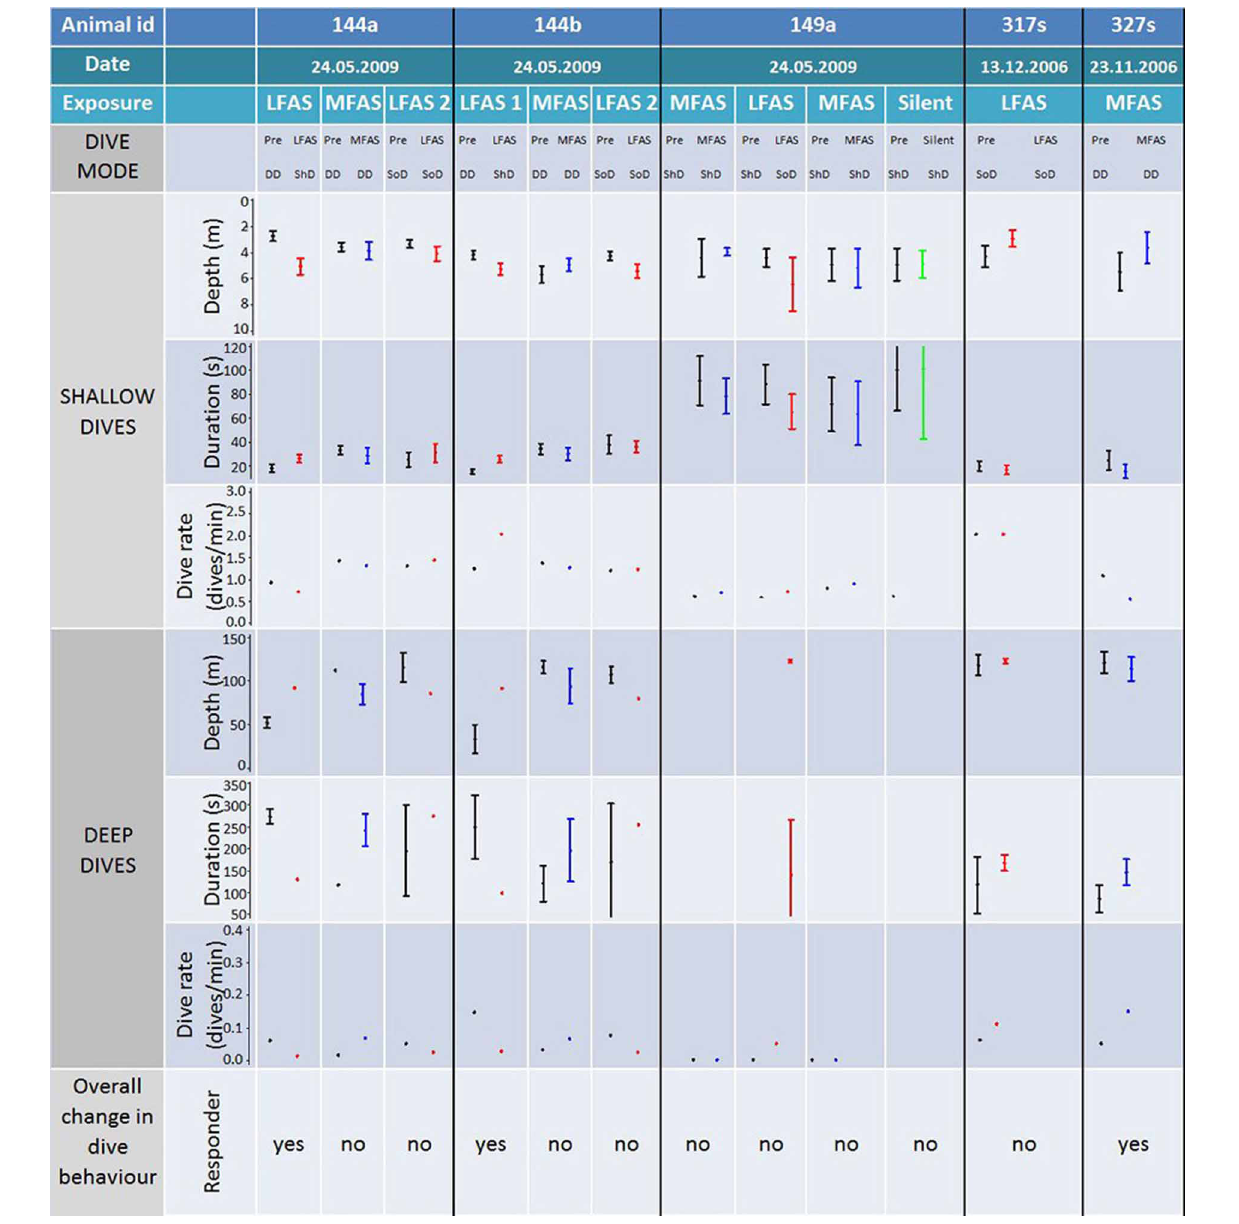
FIGURE 5 | Comparison of individual exposures to killer whales. Figure shows animal id, exposure type, dive mode (during PRE and Exposure), as well as dive depth, duration, and rate for both shallow and deep dives. Log frequency analysis defined deep and shallow dives to be deeper and shallower than 21m respectively for killer whales. Codes for dive modes are: deep diving (DD), shallow diving (ShD) and shallow diving with occasional